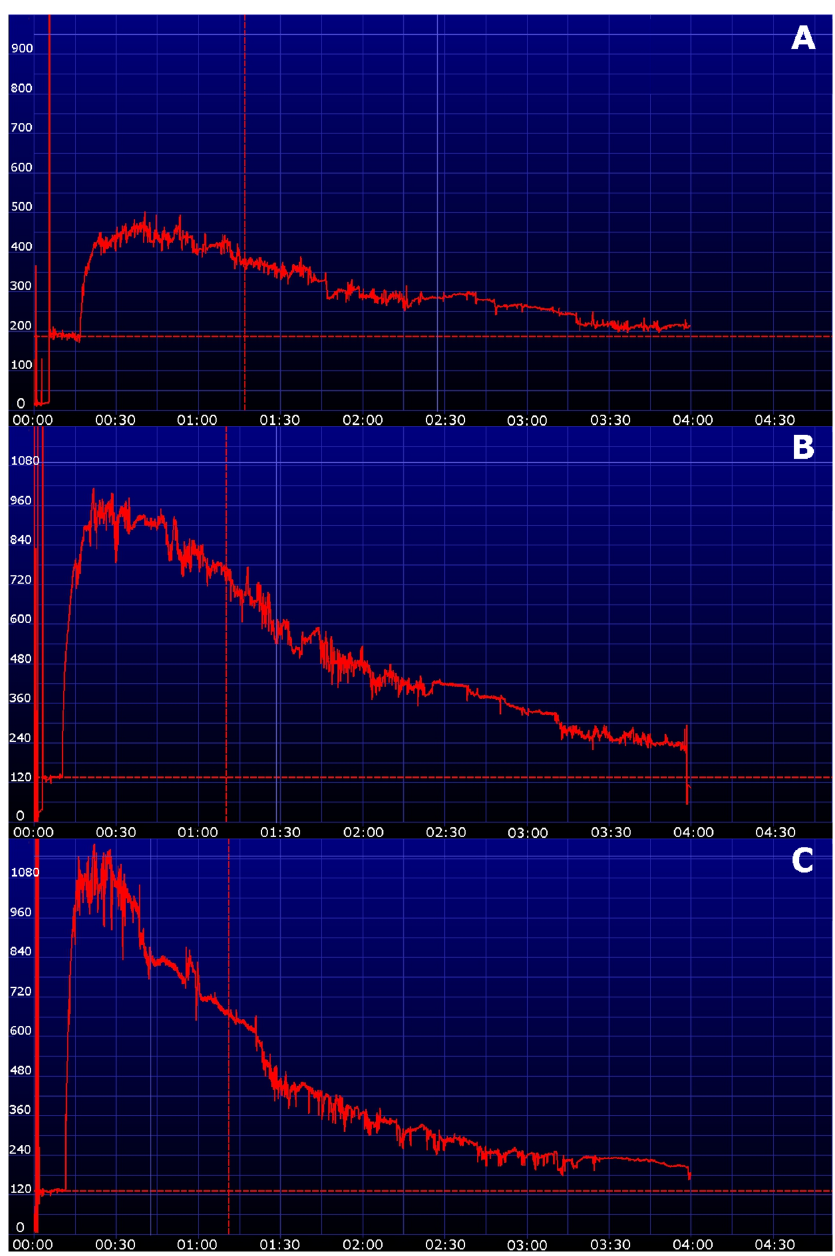
Figure 3. Transcutaneous disappearance curves of a cat using three different dosages of fluorescein- isothiocyanate-labelled sinistrin (A: 10 mg/kg, B: 30 mg/kg, C: 50 mg/kg). The x-axis represents time, the y-axis represents the relative transcutaneous fluorescence. The dose of 30 mg/kg (B) results in an adequate peak concentration.